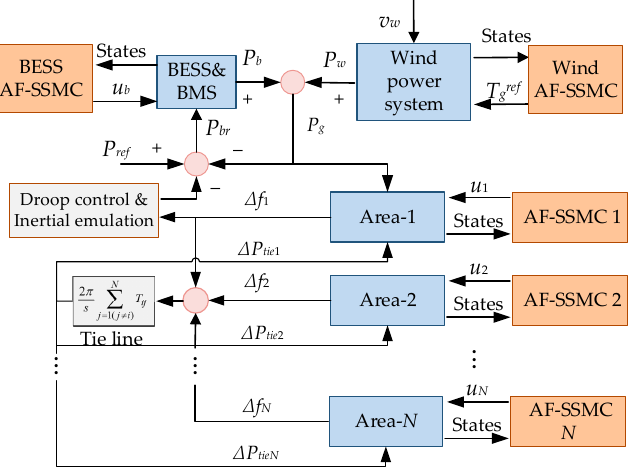
Figure 1. Hybrid power system with N areas.